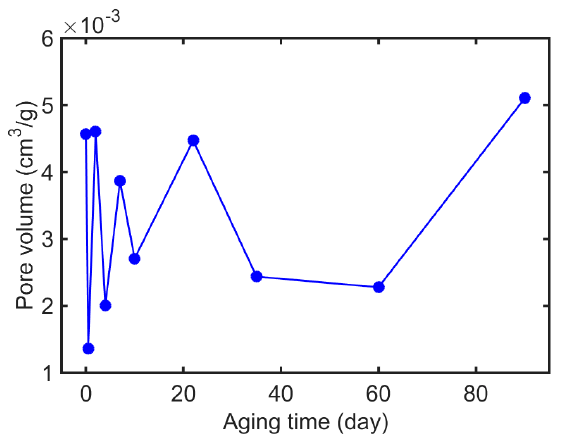
Figure 12. Pore volume of paper thermally aged for various durations at 130 °C.